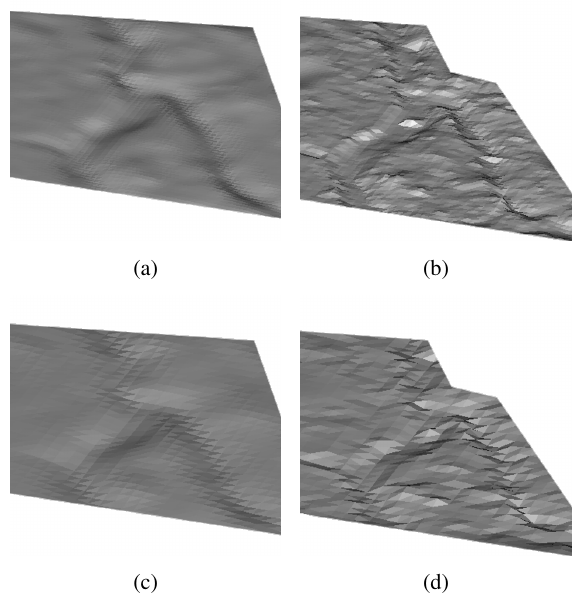
Figure 8. DEMs with different cell sizes top: cell size of 0.8 m a) DEM for the ALS data and b) DEM for the photogrammetric point cloud, bottom: cell size of 1.6 m c) DEM for the ALS